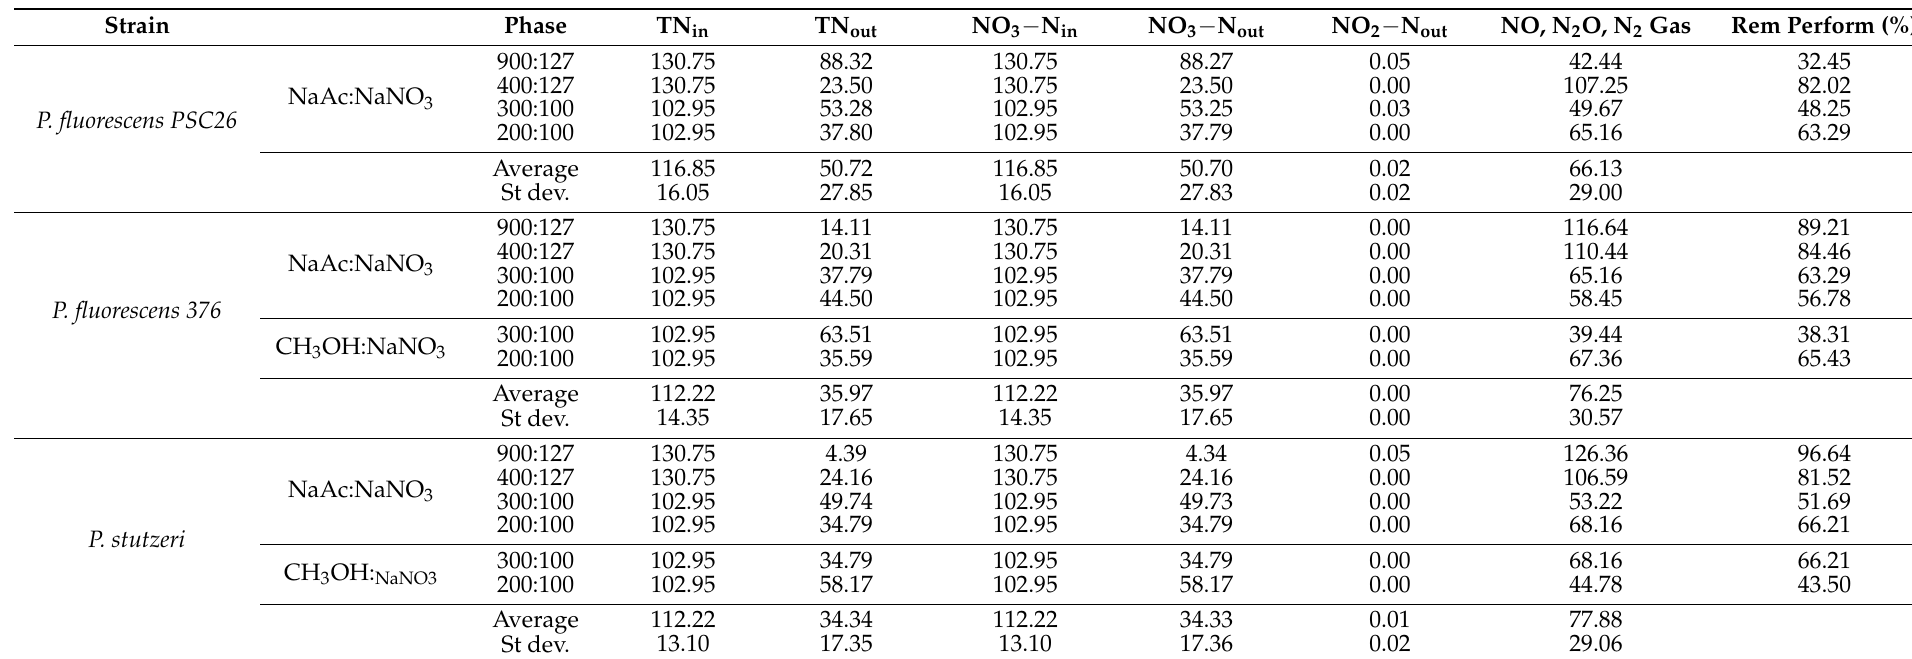
Table 2. Nitrogen mass balance expressed as mg N L − 1 during the different studies cases for P. fluorescens PSC26, P. fluorescens 376, and P. stutzeri (St dev*: standard deviation; rem perform: removal performance) P. denitrificans was not included due to not achieving